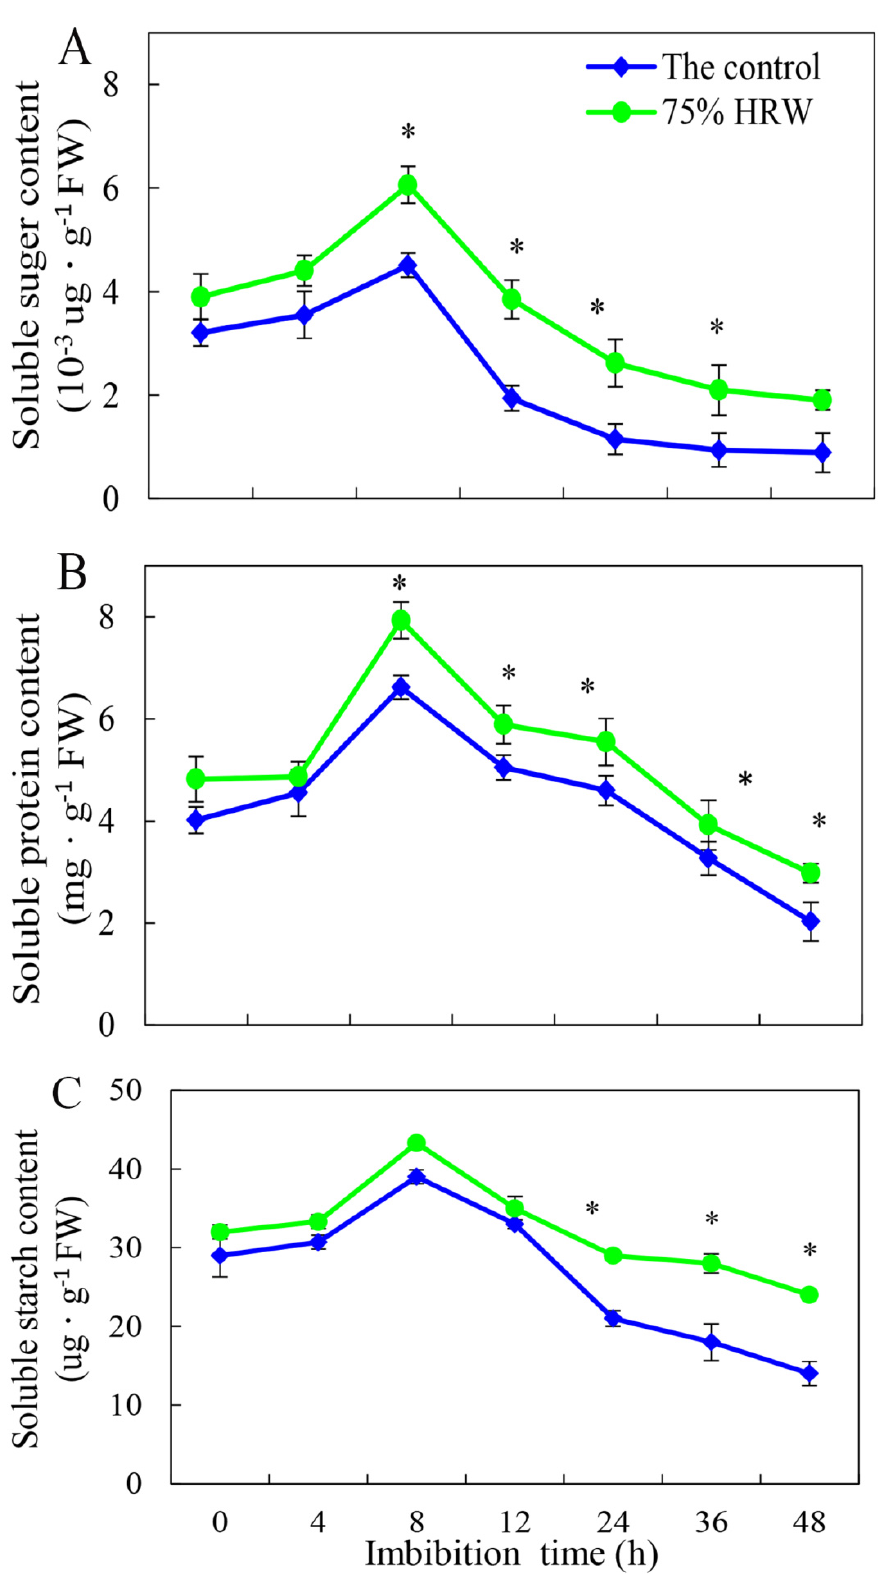
Figure 3. Changes in the contents of soluble sugars ( A ), soluble protein ( B ), and soluble starch ( C ) of cucumber seed with or without 75% HRW treatment during 48 h germination. Data are mean ± SE of three independent experiments. The asterisks denote Turkey–Kramer ′ s t -test significance under different treatments at the same time: * p < 0.05, h: hours, HRW: hydrogen-rich water.